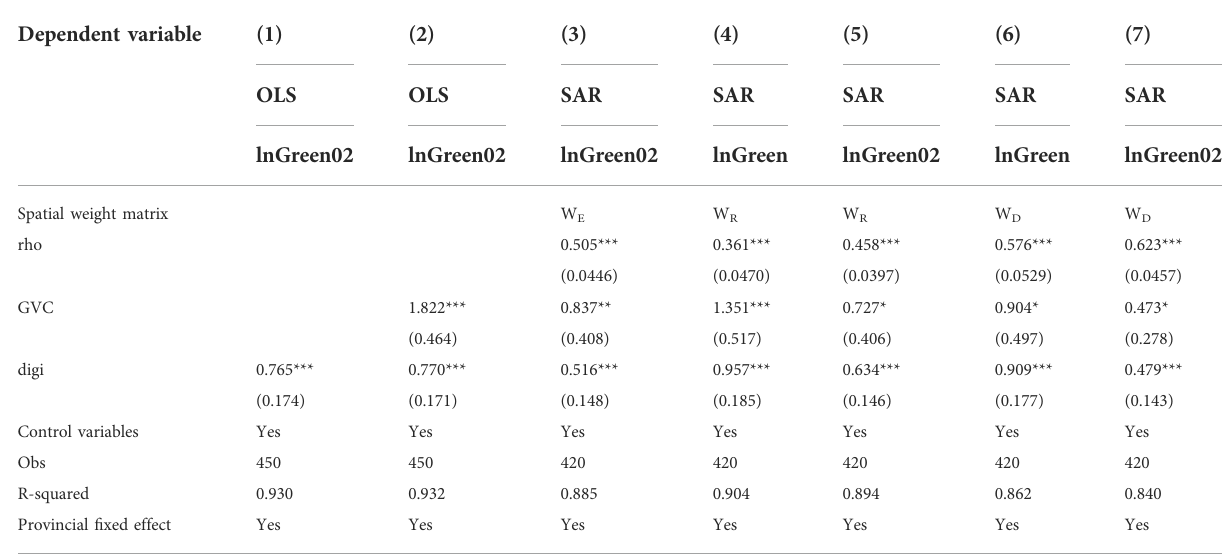
TABLE 7 Robustness test results.